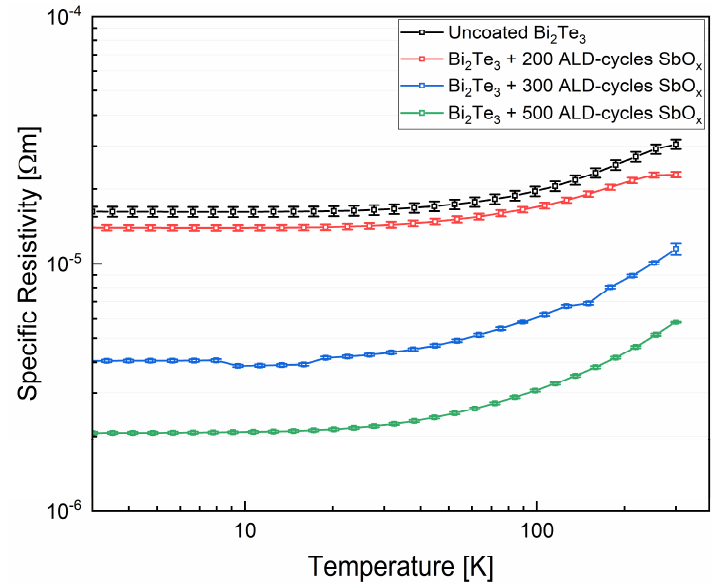
Figure 6. Double logarithmic plot of specific resistivity versus temperature of sintered pellets. Table 1. Seebeck coefficient S , total thermal conductivity κ tot , electrical conductivity σ and